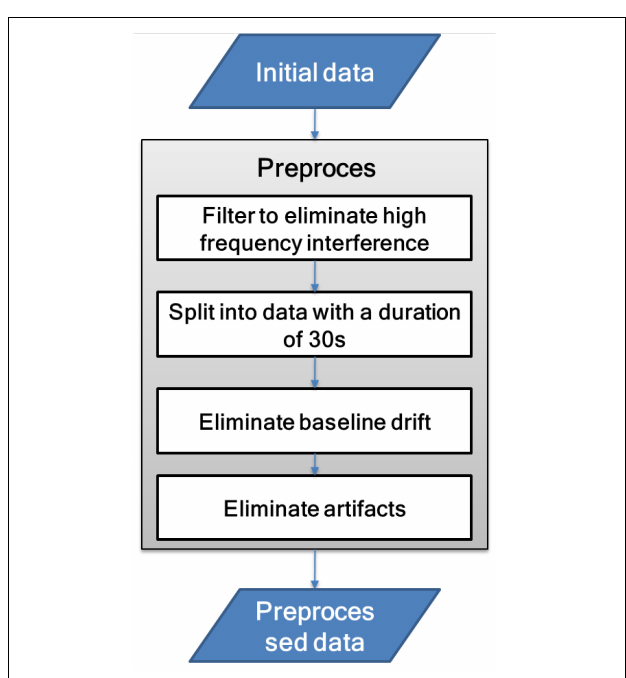
FIGURE 3 | Signal preprocessing flowchart.